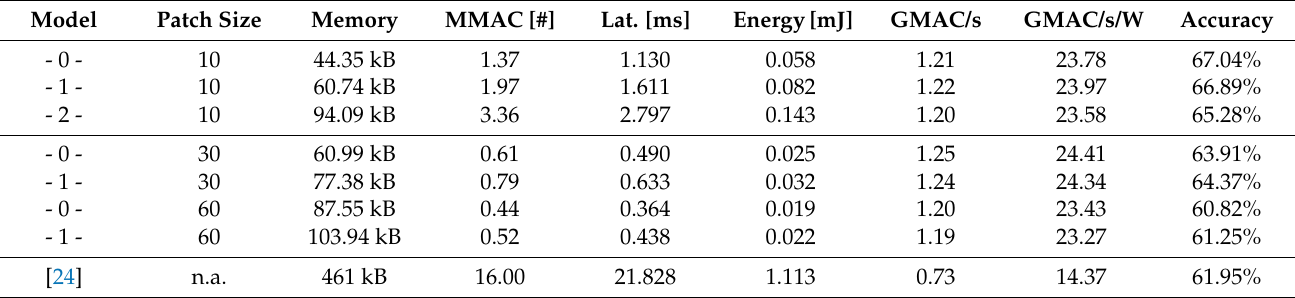
Table 2. Performance of Pareto-optimal bioformers on